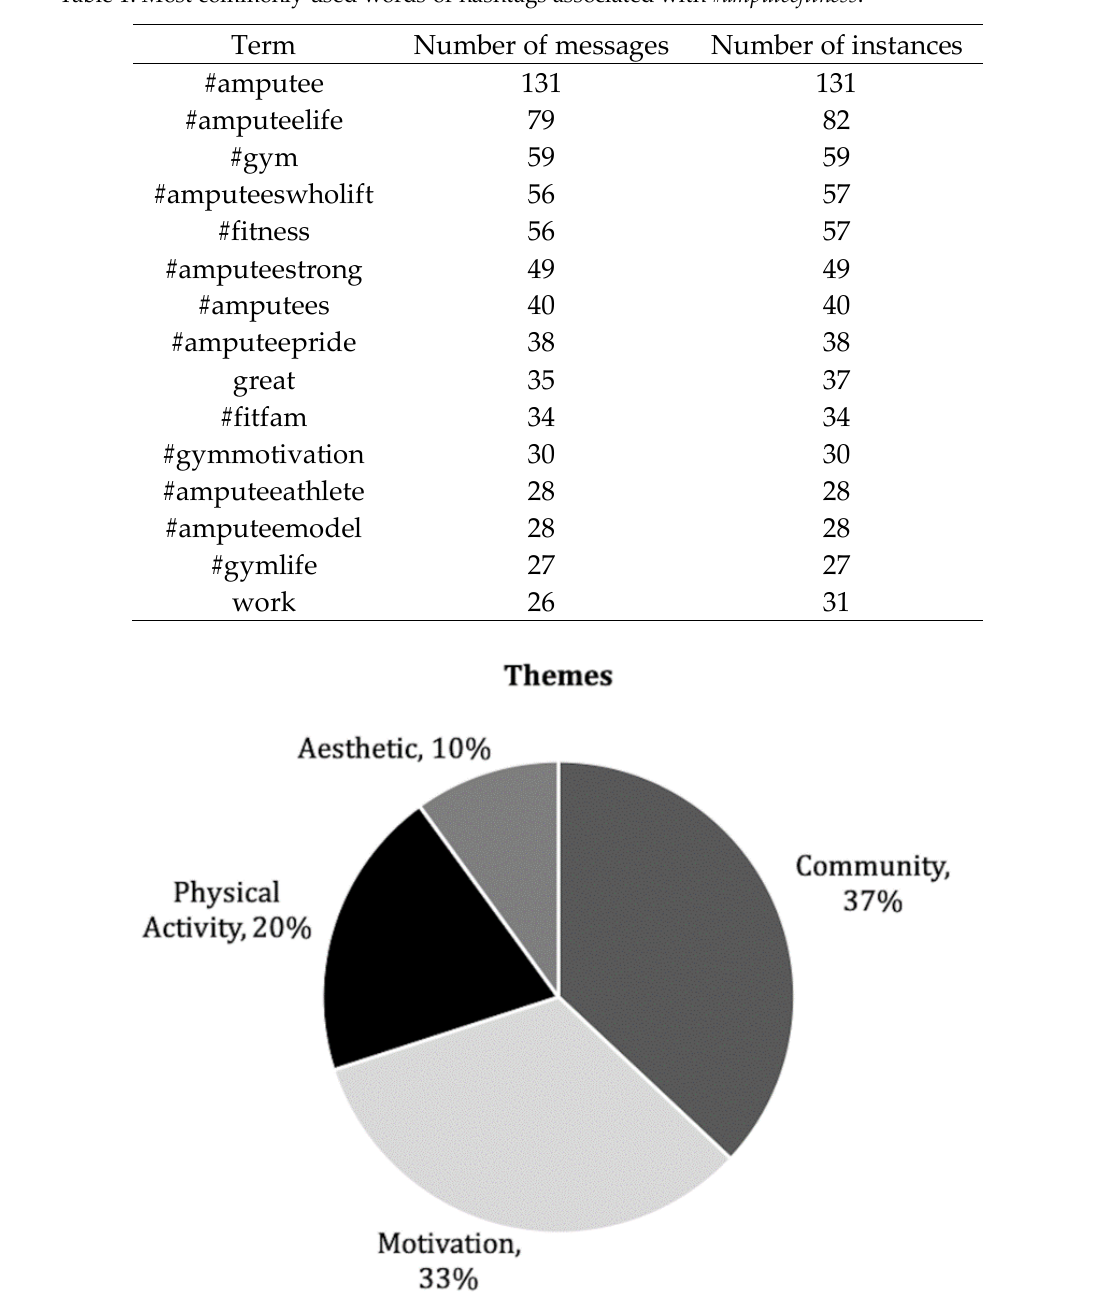
Table 1. Most commonly used words or hashtags associated with #amputeefitness .